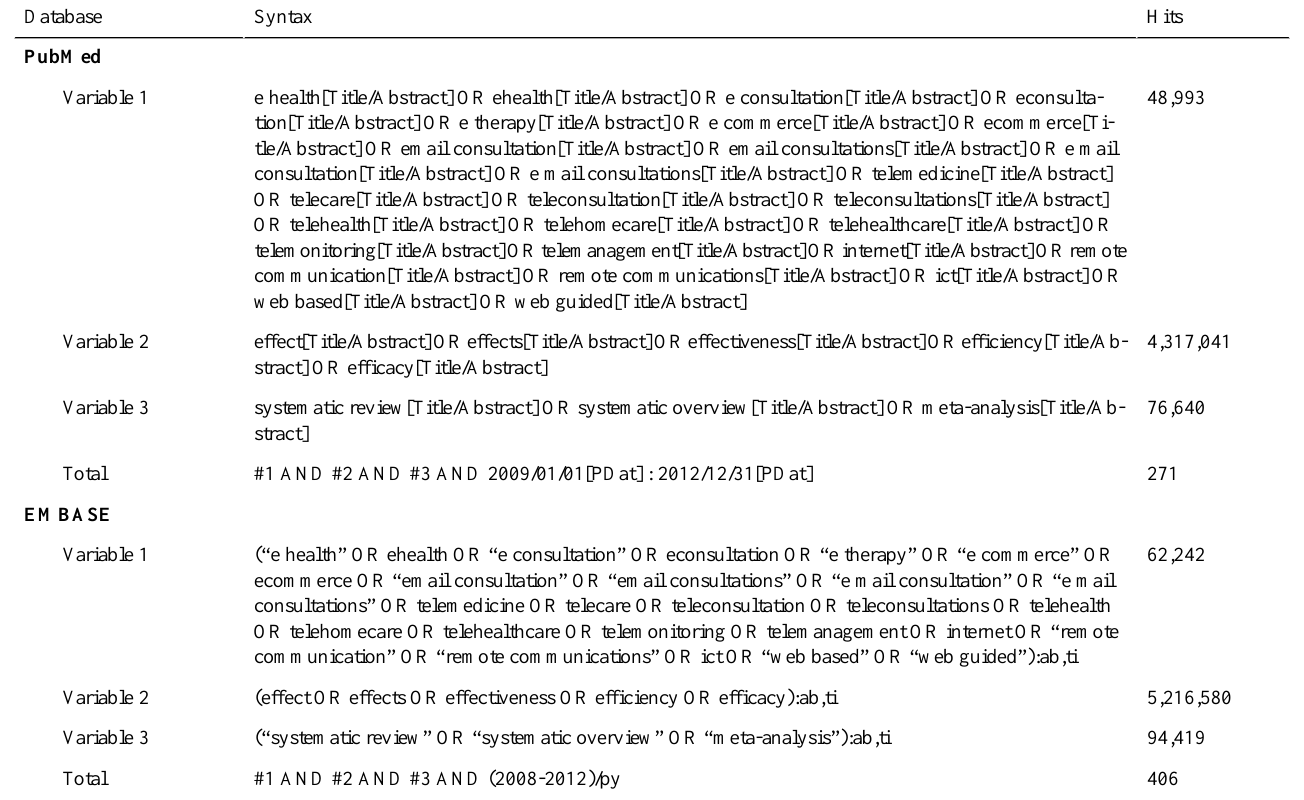
Table 1. PubMed, EMBASE, The Cochrane Library, and Scopus search queries for systematic reviews and meta-analyses on the effectiveness of eHealth interventions (search conducted on September 12,